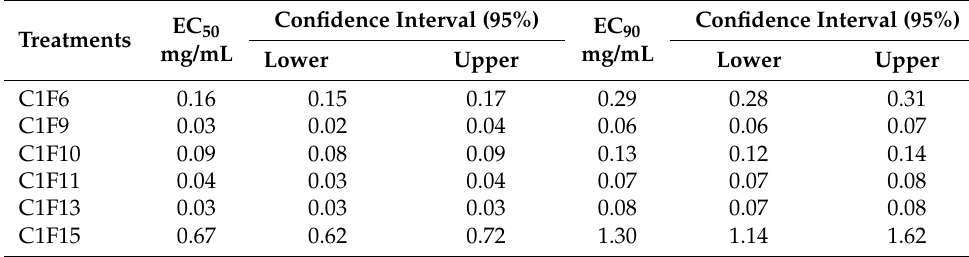
Table 4. Effective concentrations required to inhibit 50% and 90% of Haemonchus contortus egg hatching after 48 h exposure to subfractions obtained of the EtOAc